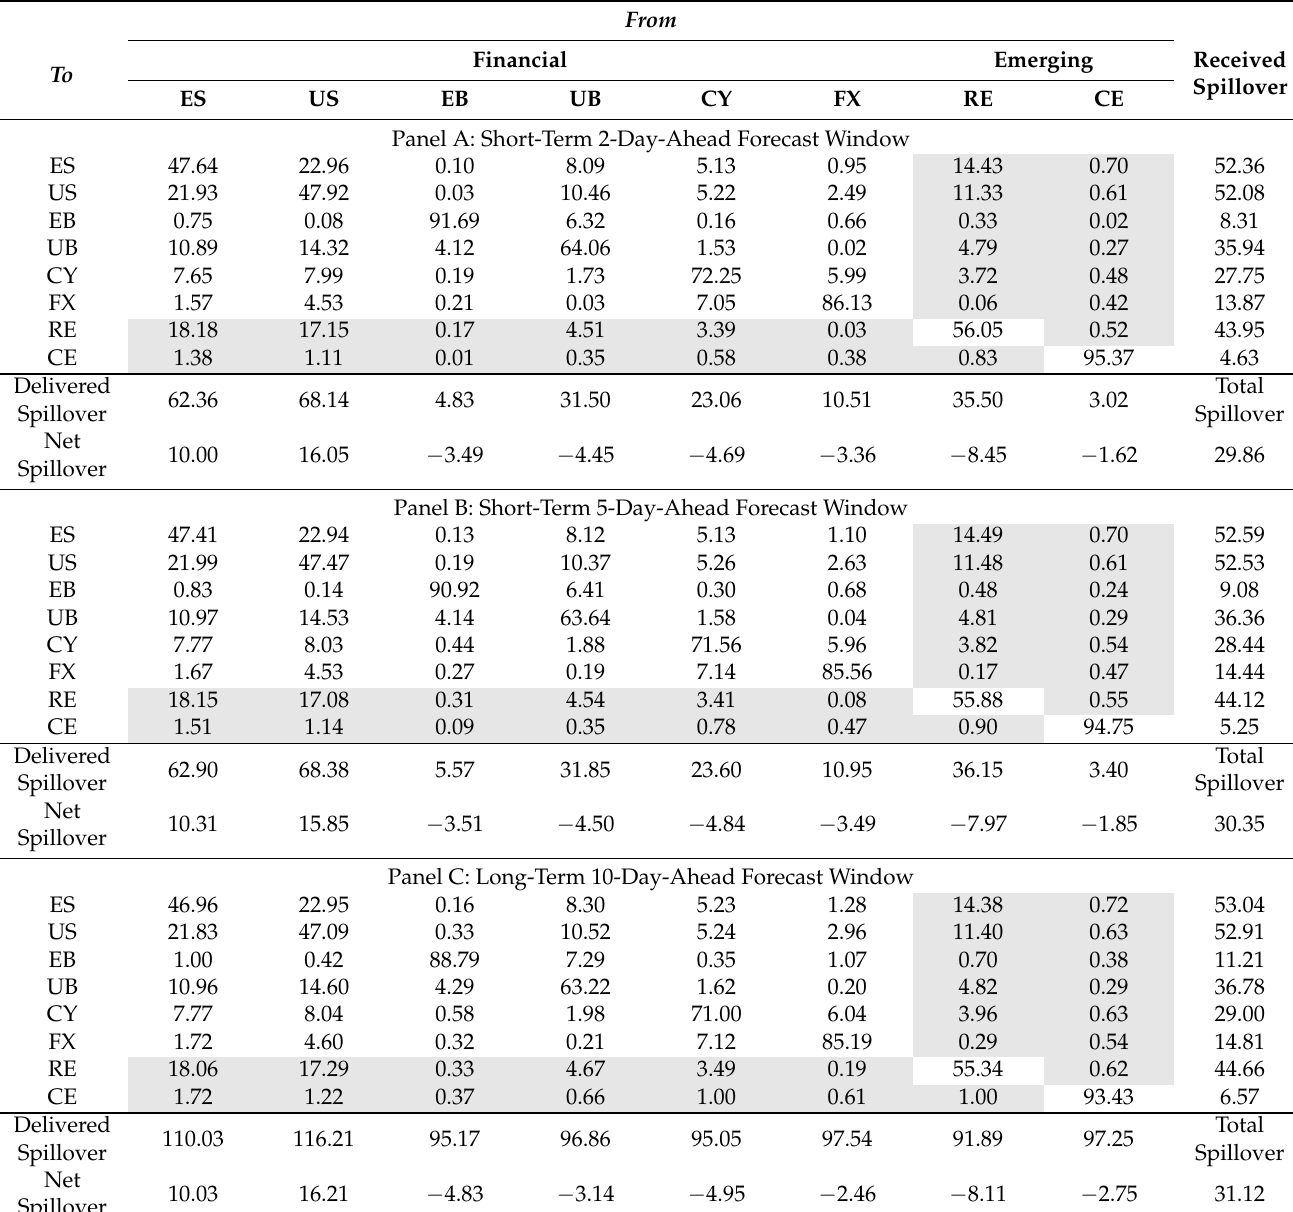
Table A3. Spillover Indexes of Financial and Emerging Markets based on Different Forecast